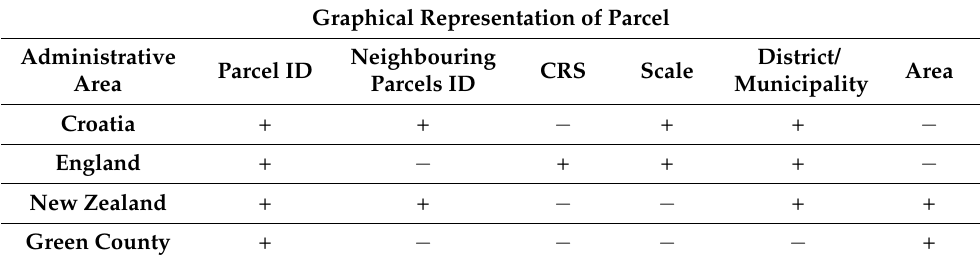
Table 1. Attribute analysis of graphical representation of